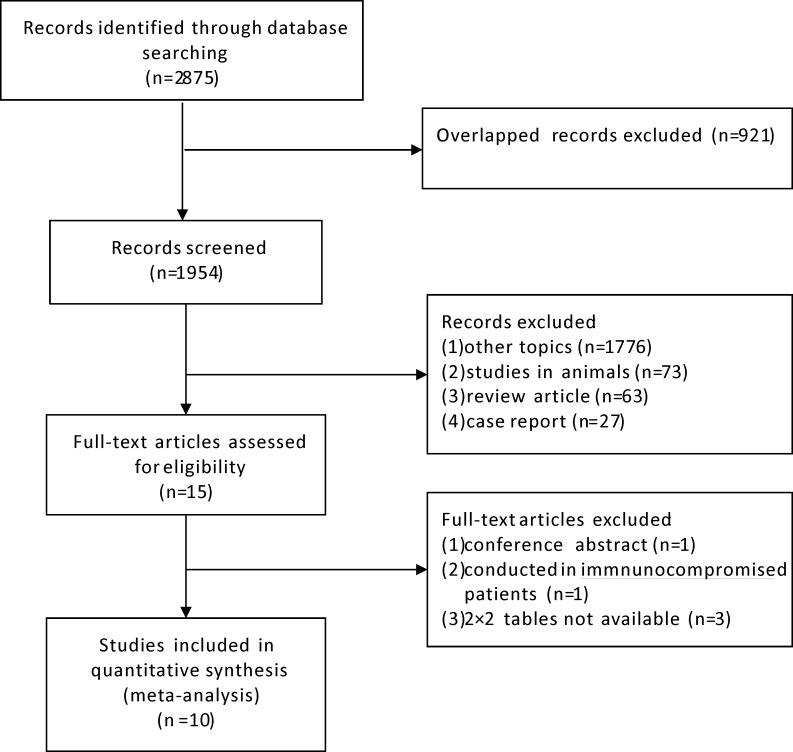
Flow diagram of included studies.